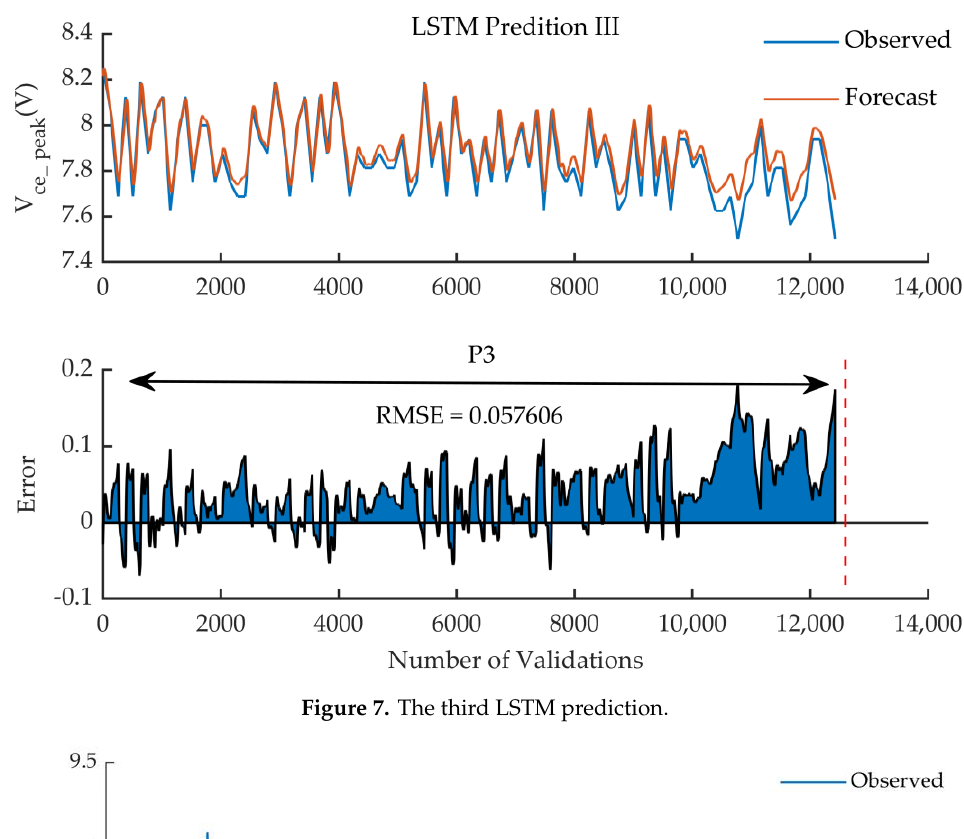
Figure 6. The second LSTM prediction.